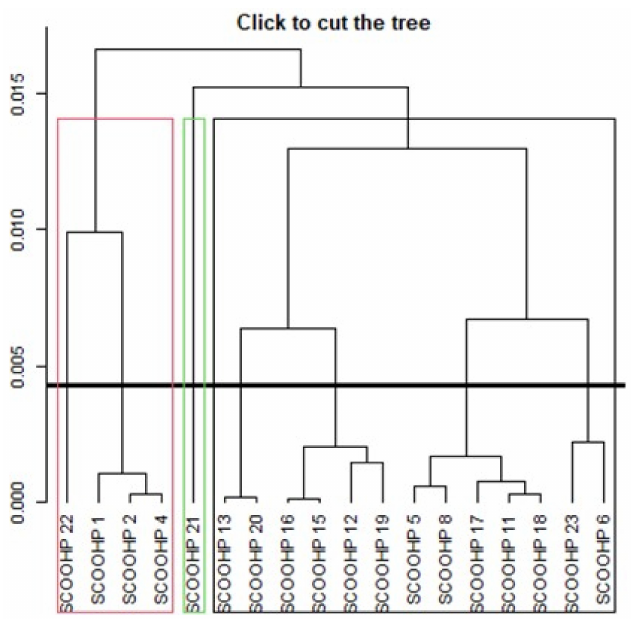
Figure 4. Individual items dendrogram for the SCOOHP scale with 18